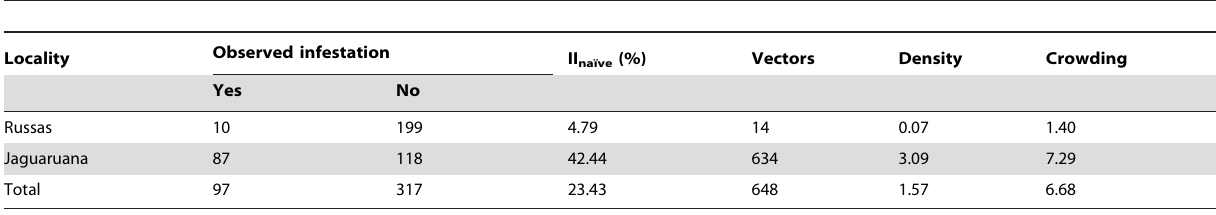
Table 3. Observed infestation by Chagas disease vectors in 414 man-made ecotopes of the lower Jaguaribe valley in northeastern Brazil: naı¨ve infestation indices and number of vectors collected.